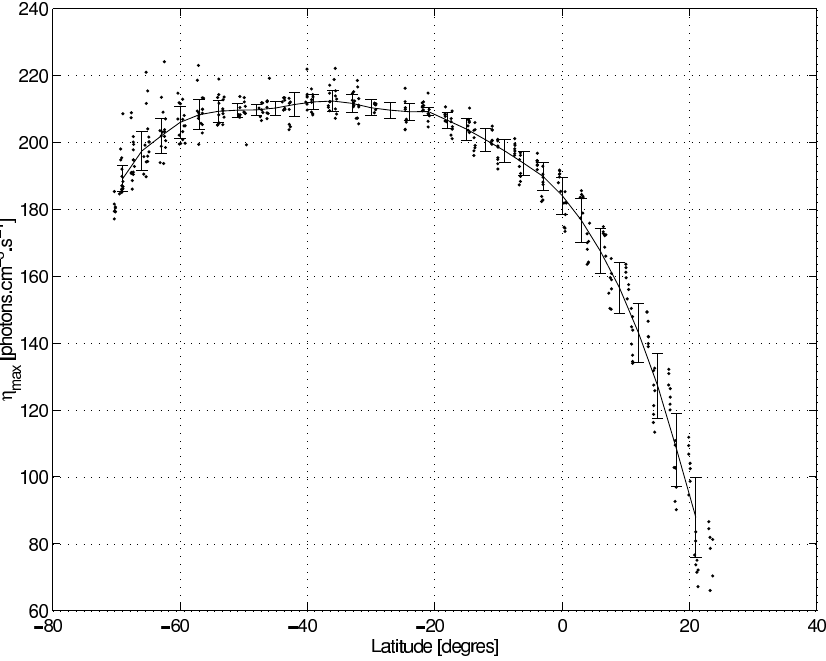
Fig. 6. WINDII data of the oxygen red emission measured on 1 April 1992 ( A p = 13, f 10 . 7 = 191 . 4). Dots represent the WINDII 630.0nm VER data plotted versus latitude, and the line represents the corresponding zonal average. Error bars indicate the standard